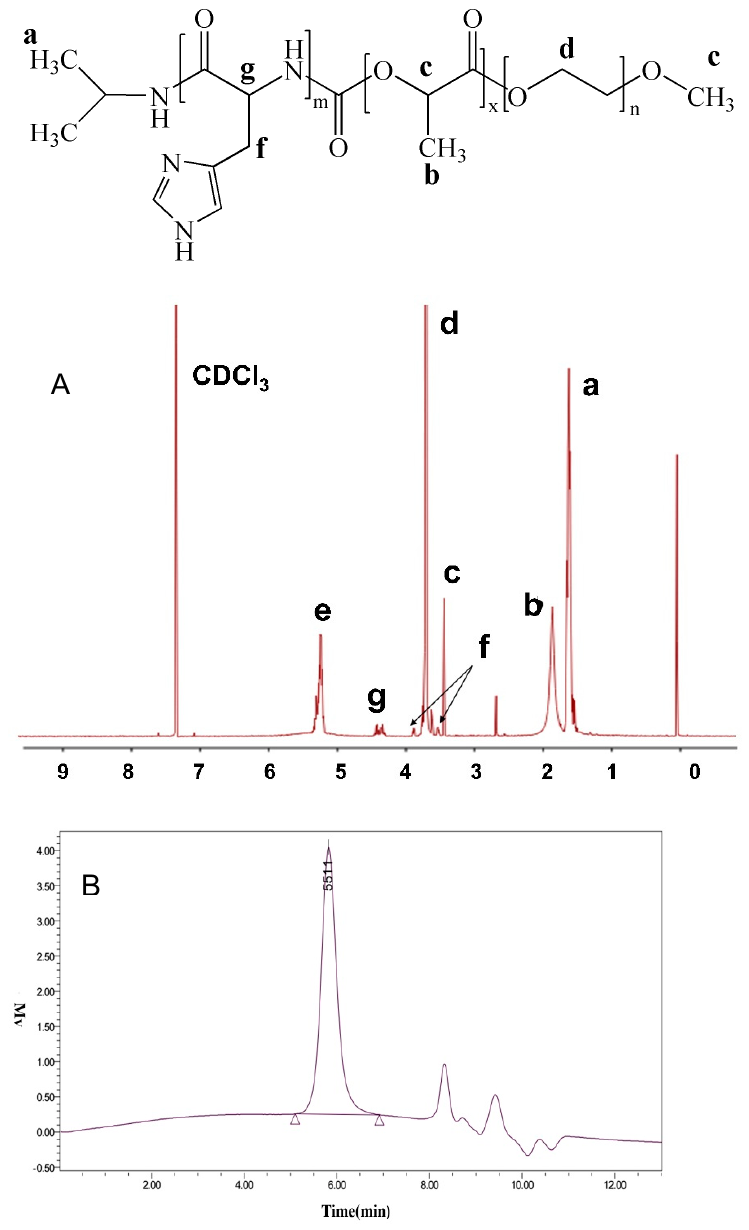
Figure 1. Typical proton nuclear magnetic resonance ( 1 H-NMR) spectrum ( A ) and gel permeation chromatography (GPC) spectrum ( B ) of mPEG-PLA-PHis